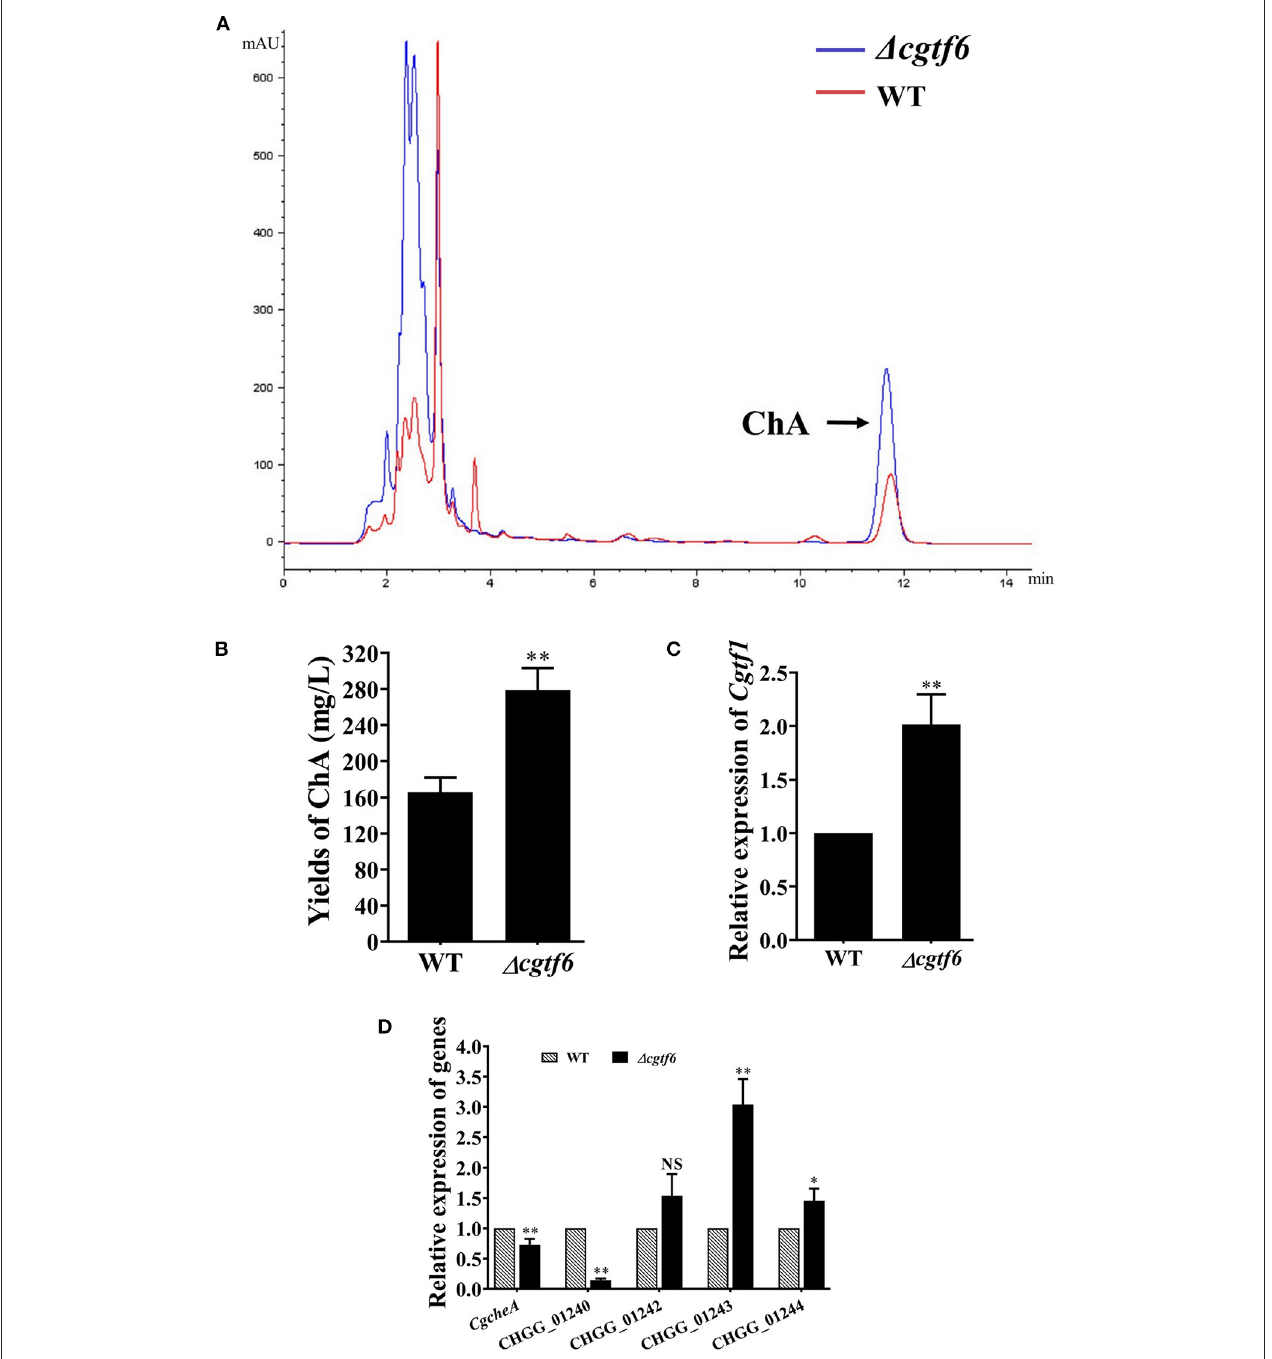
FIGURE 6 | CgTF6 deletion promotes ChA biosynthesis. (A) HPLC analysis on the production of ChA in the wild-type (WT) and the ∆ cgtf6 . The arrow indicates the peak of ChA. (B) Yields of ChA in WT and ∆ cgtf6 strains. (C) Gene expression of Cgtf1 in the ∆ cgtf6 mutant. Transcripts of Cgtf1 was normalized against GAPDH . (D) Gene expression of ChA biosynthetic gene cluster in WT and ∆ cgtf6 strains. Transcripts of all indicated genes were normalized against GAPDH . All experiments were performed in triplicate. There is significantly difference between the WT and ∆ cgtf6 as indicated by one or two asterisks ( p -value < 0.05 = *, p -value < 0.01 = **, with T -test analysis). NS: no significant